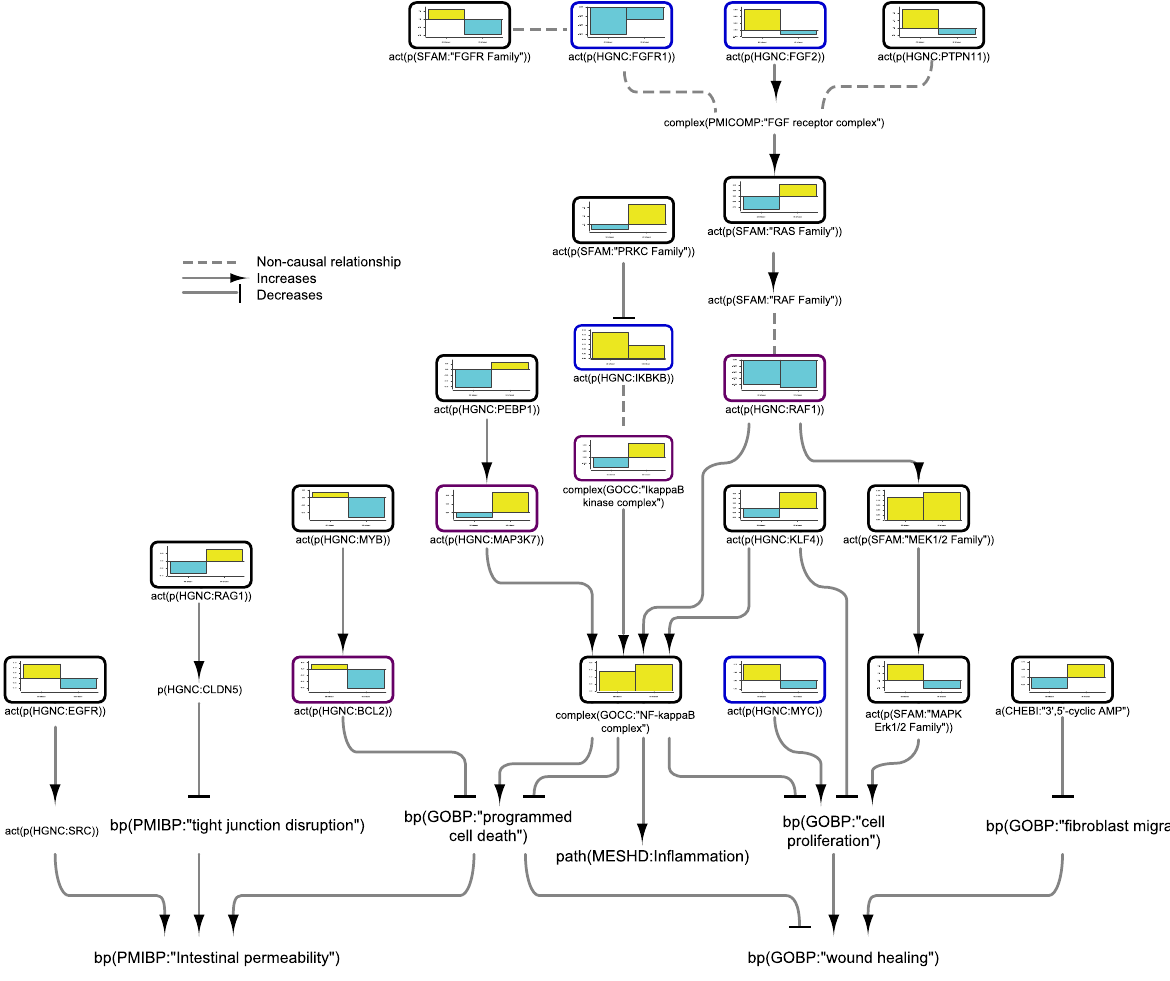
Figure 6. The minimum network with the nodes that show divergent regulation in CD and UC. The subgraph extracted from the merged IBD network model shows the iNode enrichment score for each node when the model is scored with comparative transcriptomic data from IBD-affected versus healthy control samples. The values are not comparable between the graphs, and the scale is adjusted on the basis of the highest value for each node. Most intermediate nodes that were not scored have been removed for simplicity (The complete results are in Supplementary file 1). Black outlines indicate nodes that were significantly impacted in both CD and UC samples; blue outlines indicate nodes that were significantly impacted in CD samples; and purple outlines indicate nodes that were significantly impacted only in UC samples. The directionalities are shown as yellow or turquoise bars for inferred upregulation or downregulation, respectively. The order is as follows: 1) CD and 2) UC. Abbreviations: act, protein activity; p, protein abundance; bp, biological process. HGNC is the namespace for human proteins; GOBP is the namespace for biological processes; MESHD is the namespace for diseases; and GOCC is the namespace for complexes. SFAM and PMIBP are custom namespaces for protein families and biological processes, respectively. The figure was created using Cytoscape v3.7.1 (https:// cytos cape. org). The Cytoscape graph was then exported to pdf and the layout was further modified for better readability in Adobe Illustrator 2019 (https:// adobe.